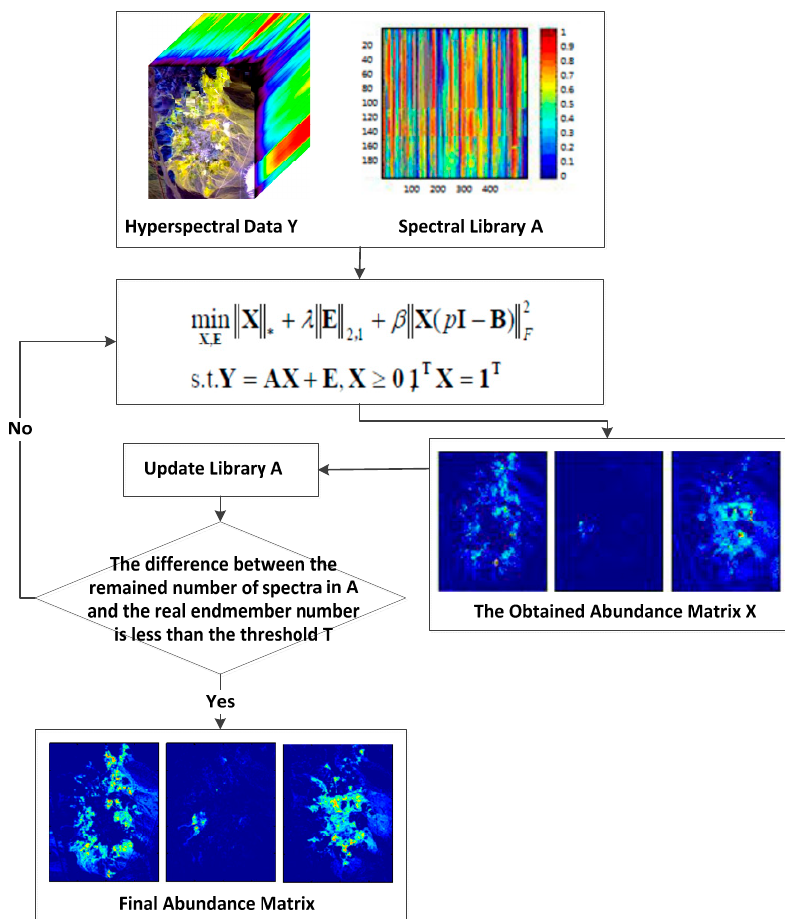
Figure 1. The flow chart of the proposed method.